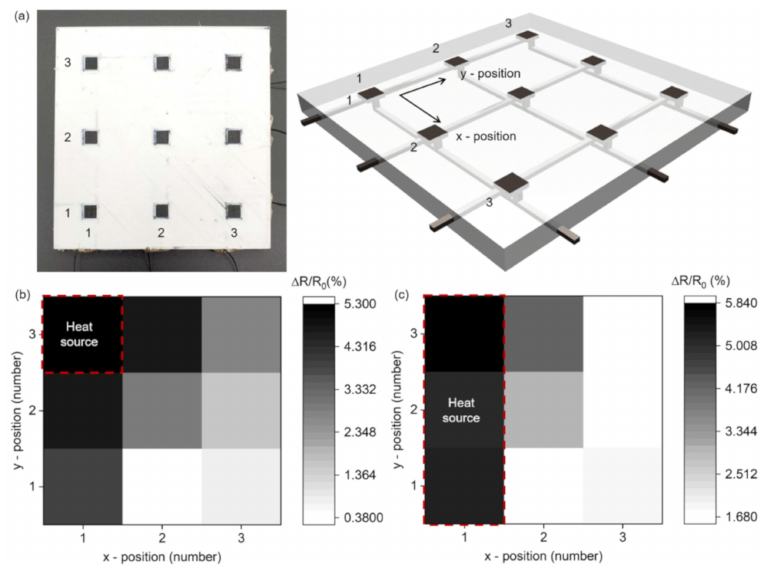
Figure 4. ( a ) Optical image of the fabricated 3 × 3 array of P-RTDs (left panel) and its drawing for three-dimensional printing (right panel); resistance changes of the array ( b ) with a contact point of heat source at the (1,3) position; and ( c ) with a line contact across (1,1), (1,2), and